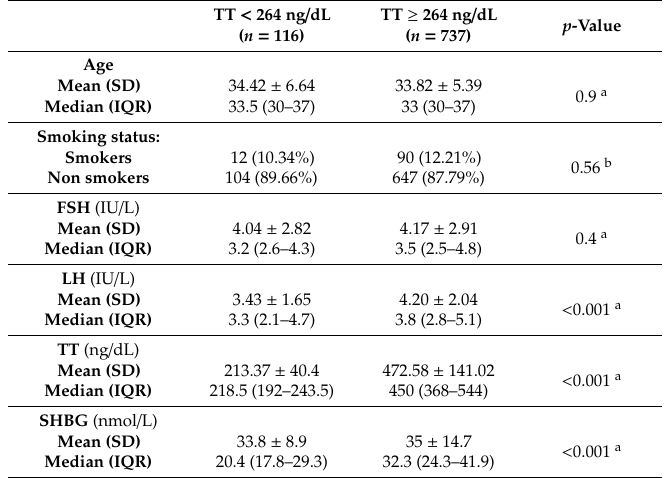
Table 1. Comparison of patient baseline characteristics between the two groups: low TT and normal TT.